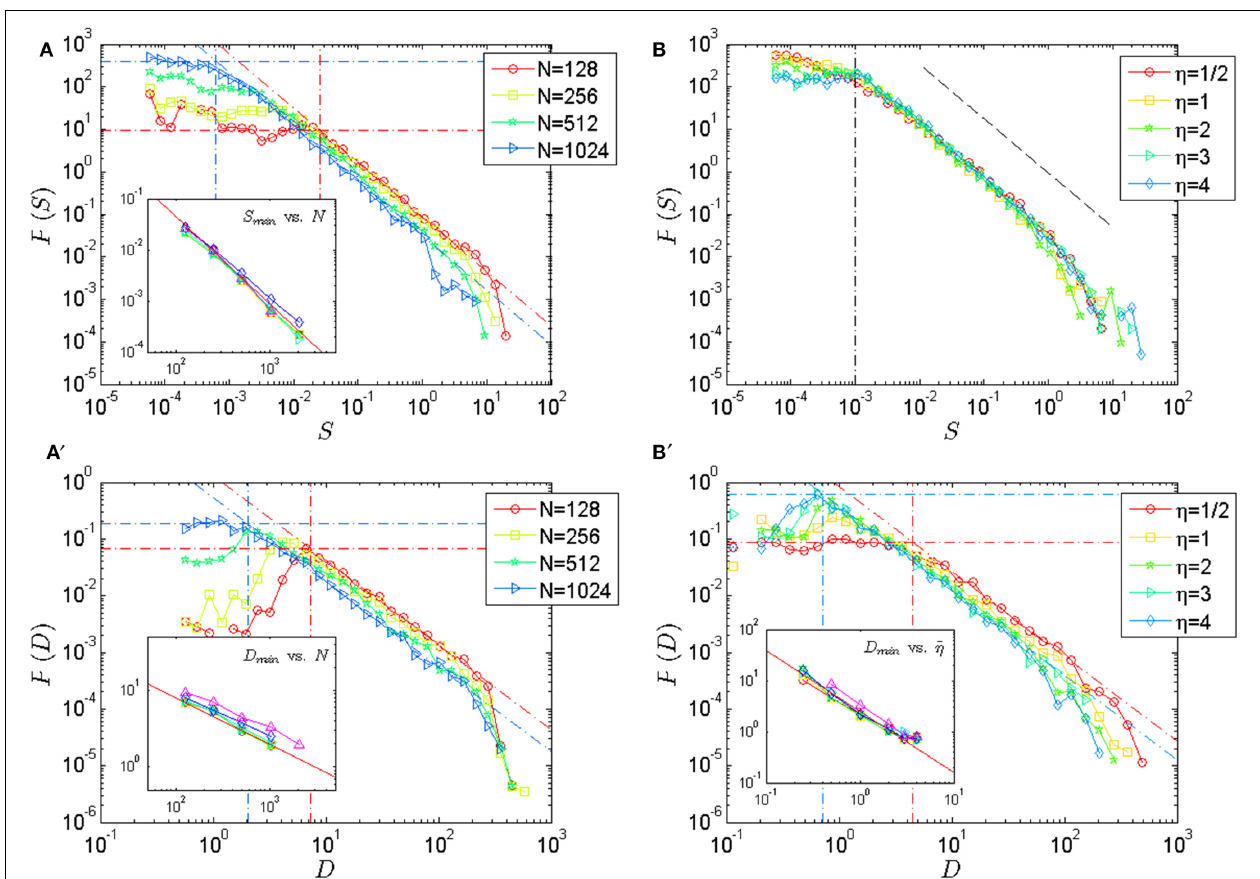
observed to be independent of ˜ η and to decrease with N . Regarding the duration,thelowercutoff D min decreaseswithboth N and ˜ η . S min (resp. D min )is quantitatively defined as the intersection of the power-law regime with exponent τ (resp. α ) and the saturation value for P observed at small S (resp. small D ). The red and blue dash lines in ( A,A (cid:6) ,B (cid:6) ) present illustrations for N = 128 and N = 1024, respectively. The variation of S min with N is shown in the inset of a . The variations of D min with N and ˜ η are shown in the insets of (A (cid:6) ,B (cid:6) ) . The different symbols correspond to different values for c (from 2 × 10 − 6 to 10 − 4 ). The red line are fits: S min ∝ N − a SN with a SN = 1 . 7 ± 0 . 1, D min ∝ N − a DN with a DN = 0 . 6 ± 0 . 1, and D min ∝ ˜ η − a D ˜ η with a D ˜ η = 1 . 2 ± 0 .